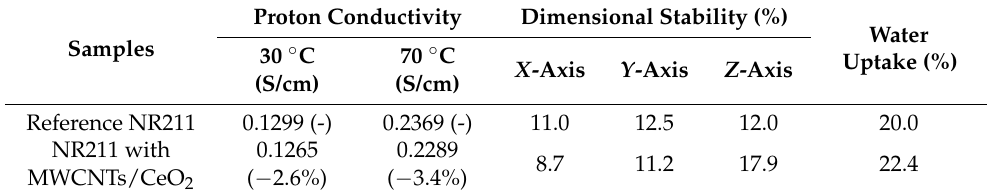
Table 1. Summary of ion conductivity, dimensional stability, and water uptake.